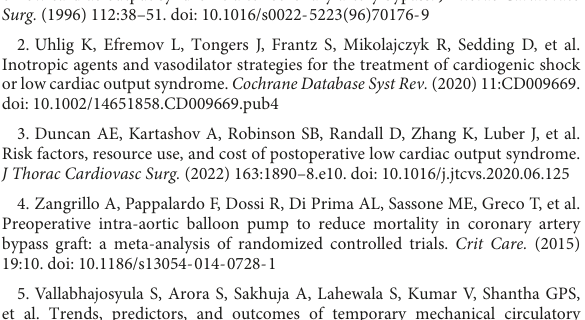
SUPPLEMENTARYFIGURE2 Prognosis variables in patients with LCOS diagnosed by CI criterion and other criteria and patients without LCOS, including mechanical ventilation time (A) , ICU stay time (B) and hospital stay time (C) . SUPPLEMENTARYFIGURE3 Feature importance determined through Boruta algorithm. SUPPLEMENTARYFIGURE4 Subset feature selection through Lasso